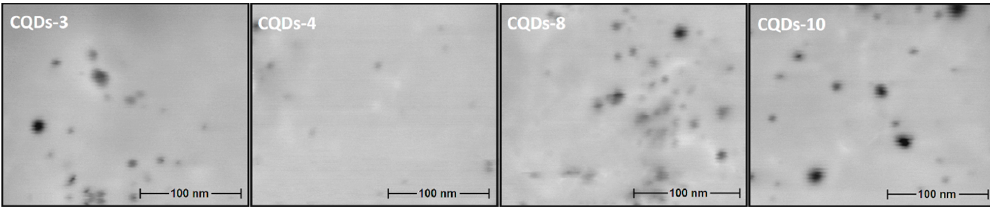
Figure 4. Size distribution of the ( a ) CQD-3, ( b ) CQD-4, ( c ) CQD-8 and ( d ) CQD-10 samples.